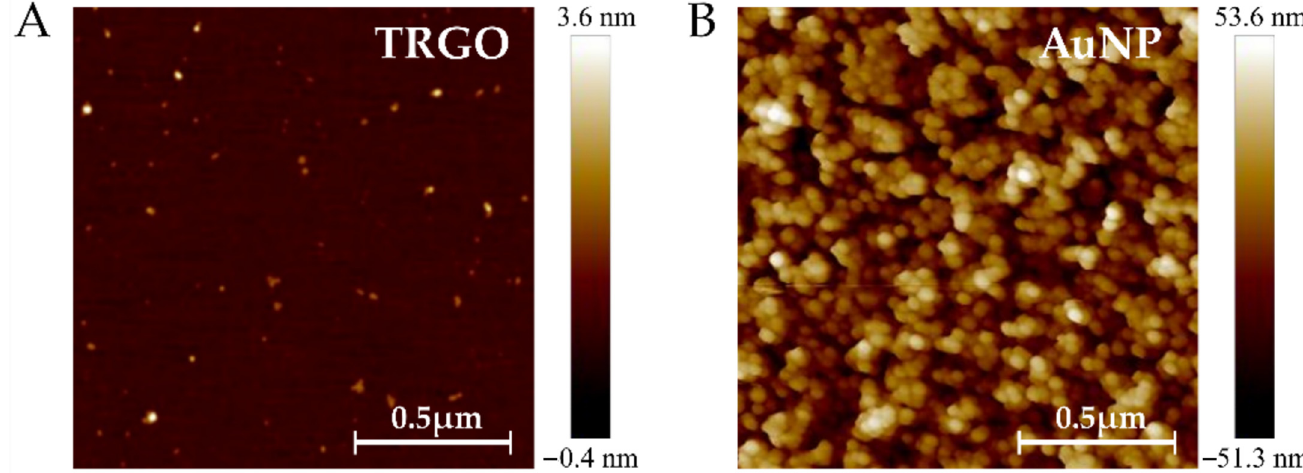
Figure 3. Two-dimensional AFM images of the TRGO deposited on the silica plate ( A ) and AuNP deposited on flat gold ( B ). AFM images were obtained by the tapping mode in air.